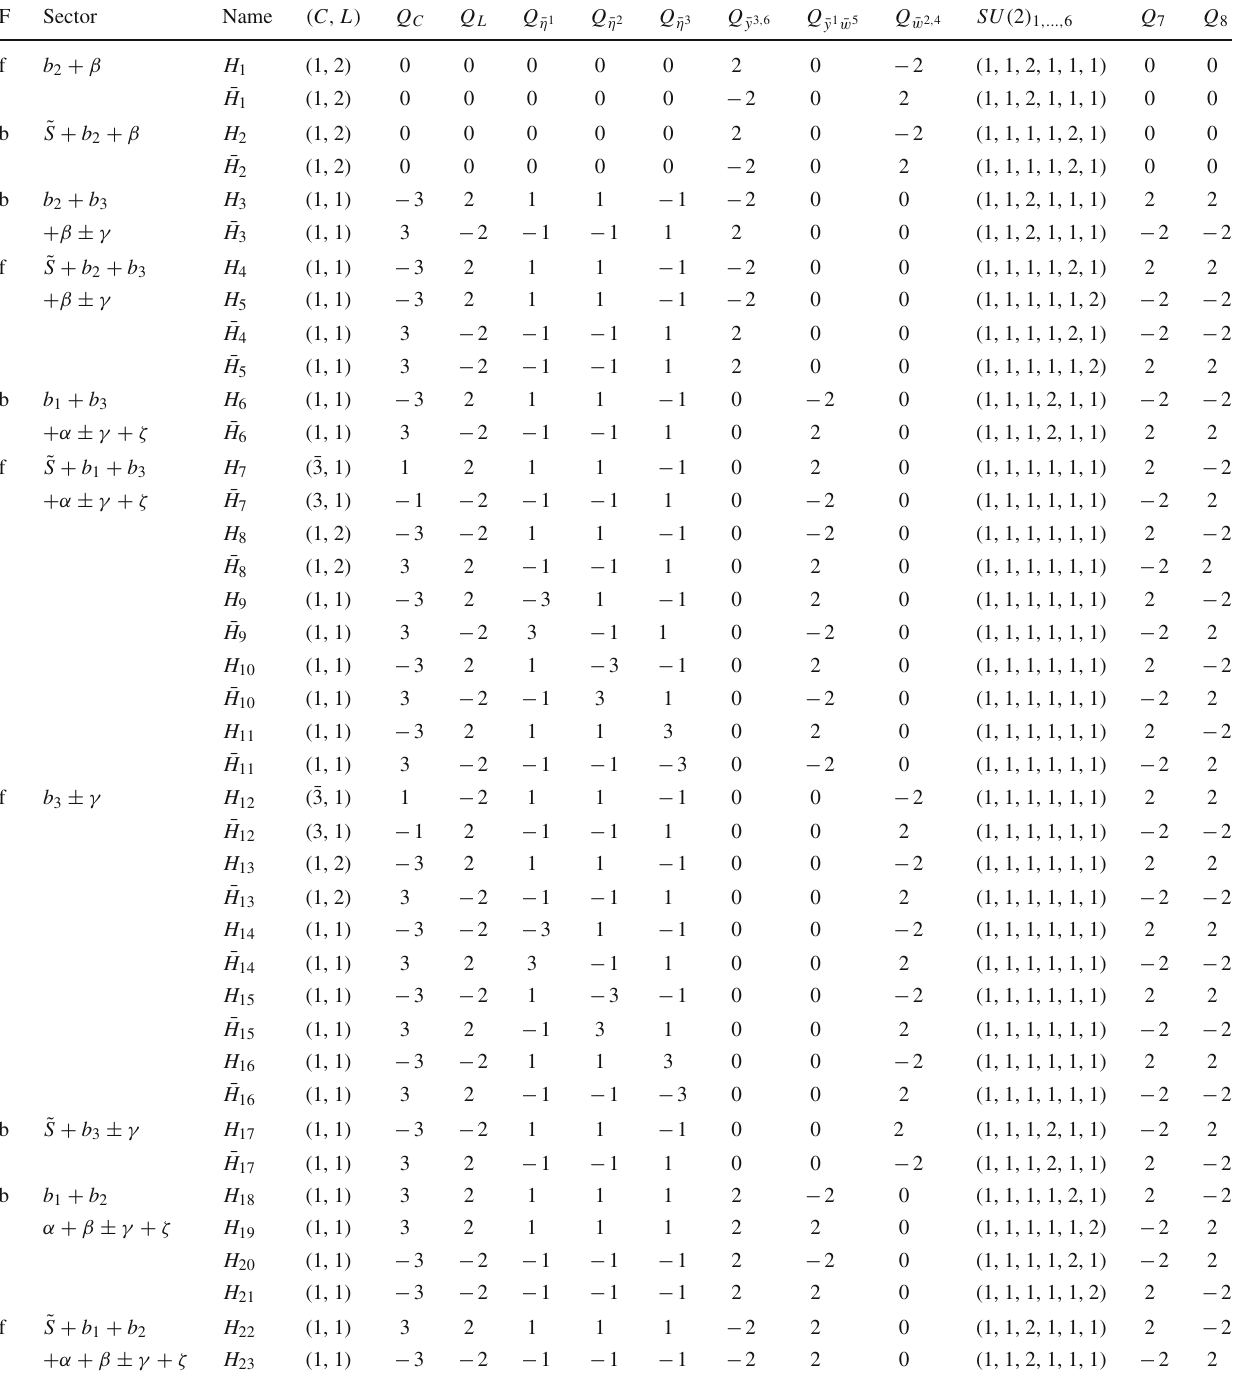
Table 7 Exotic states with ˜ S -partners (i). All charges are multipled by 4 and the combination ζ = 1 + b 1 + b 2 + b 3 has been used F